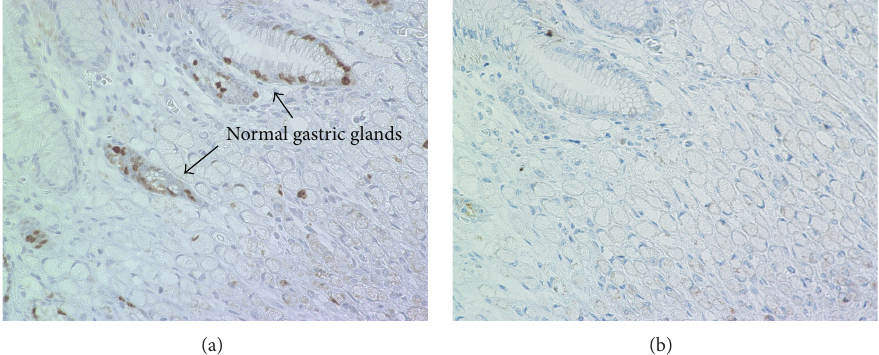
Figure 4: Immunohistochemical staining. Tumor cells were negative for Ki-67 ((a) × 40) and p53 ((b) ×